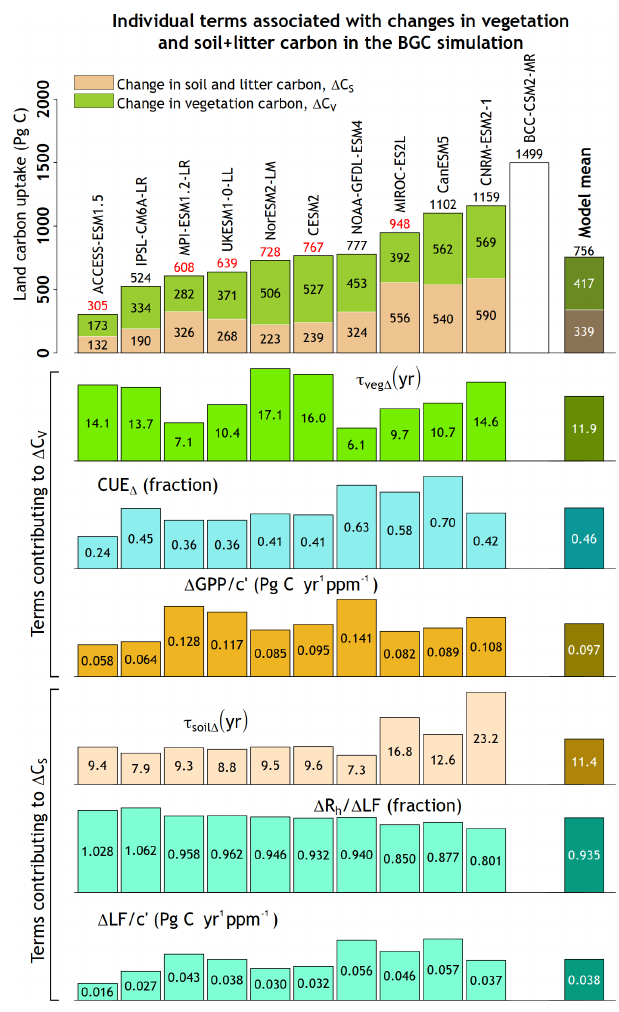
Figure 8. Individual terms of Eq. (8) which contribute to changes in vegetation ( (cid:49) C V ) and litter + soil ( (cid:49) C S ) carbon pools. Values from the BCC-CSM2-MR model are not used in calculating the model